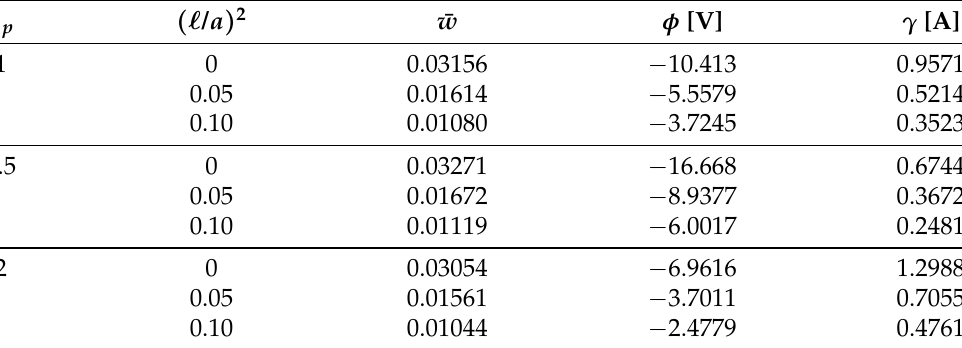
Table 6. Displacement ¯ w , electric and magnetic potential φ and γ , of a square nanoplate in central point ( a /2, b /2 ) for different values of nonlocal parameter ( (cid:96) / a ) 2 and n p (UDL; q = 10 3 N/m 2